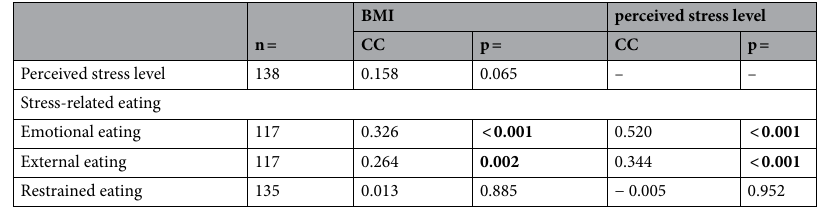
Table 2. Association between Body Mass Index (BMI), perceived stress (PSS-10) and stress-related eating behaviour in the intervention and control group (combined). Significant values are in bold. BMI Body Mass Index (kg/m 2 ), CC Pearson correlation coefficient, p